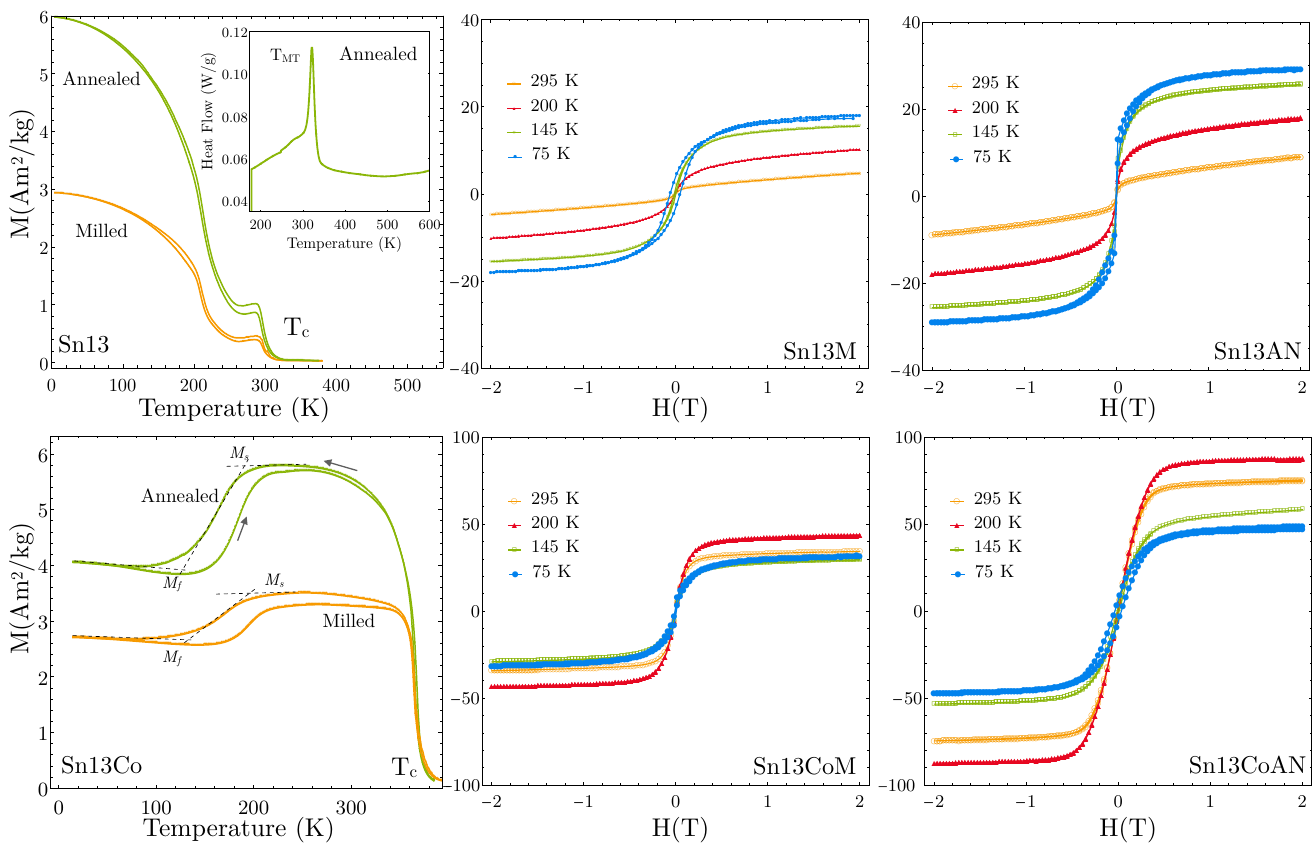
Figure 2. From left to right, M ( T ) curves and M ( H ) curves for Sn13M, Sn13AN samples (top row) and for Sn13CoM and Sn13CoAN samples (bottom row) recorded at several temperatures. The inset in Sn13 sample shows the direct martensitic transformation peak (on cooling) of the annealed Sn13 sample. In all the milled samples the magnetization decreases in comparison with their annealed counterparts. Additionally, the Co-doped sample shows a larger M s